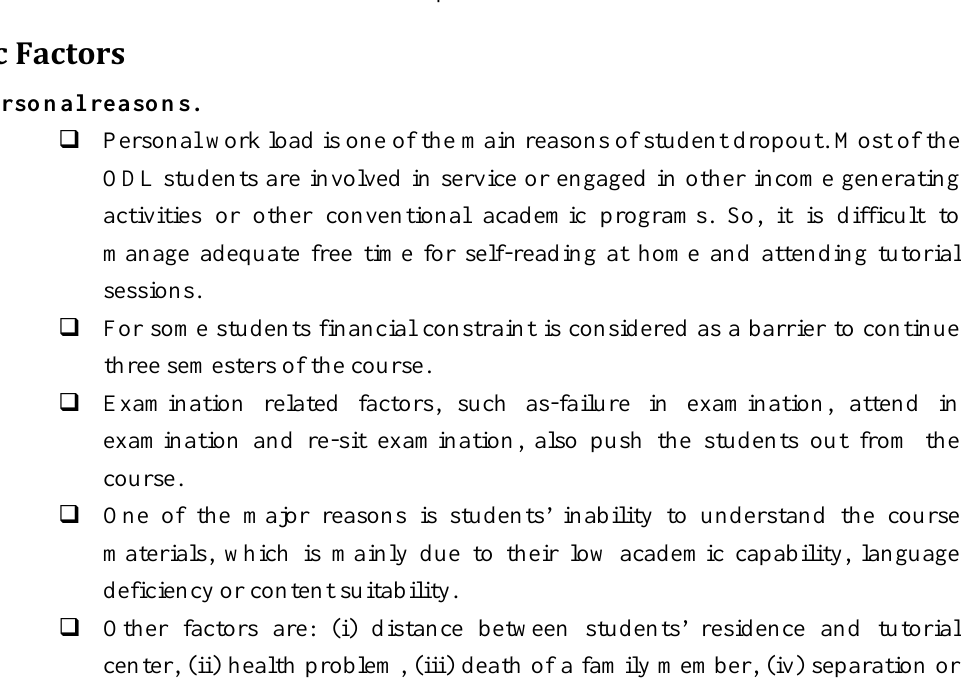
Figure 3: Push factors accountable for student dropout from the course. Intrinsic